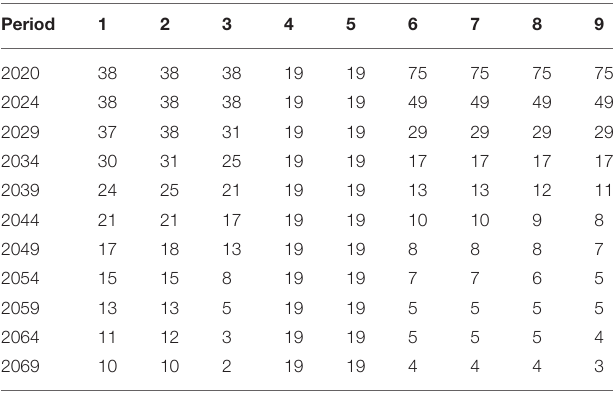
applied and 1,680 kg ha − 1 of cotton irrigated with 432 mm